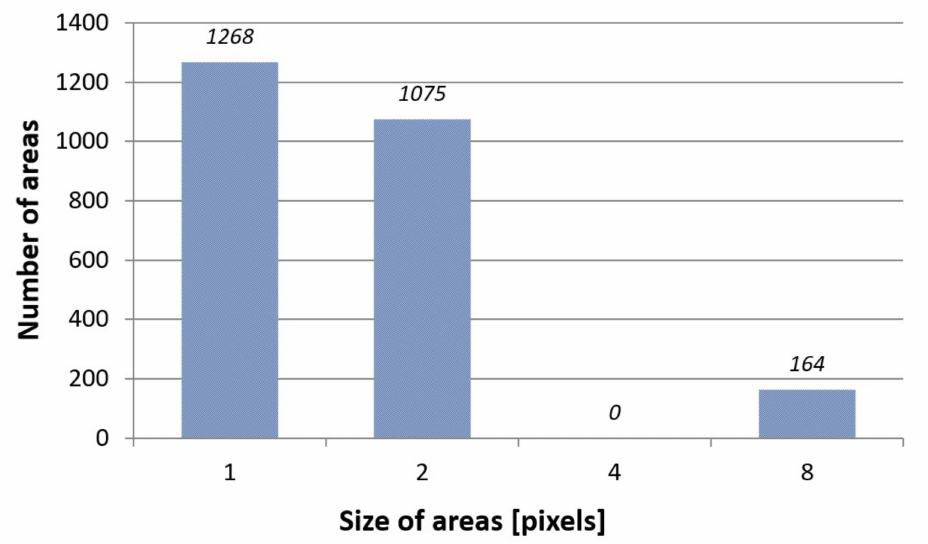
Figure 9. Histogram of the number of square areas in quadtree decomposition for the brightness threshold of one MF sample.